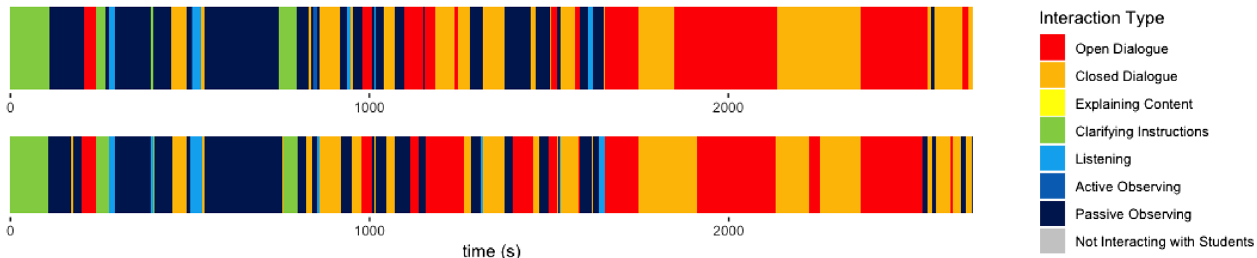
FIG. 3. Comparison of two observers ’ categorizations during a representative 45-minute interval. Definitions of the categories are found in Table V. Not all interaction types were observed during